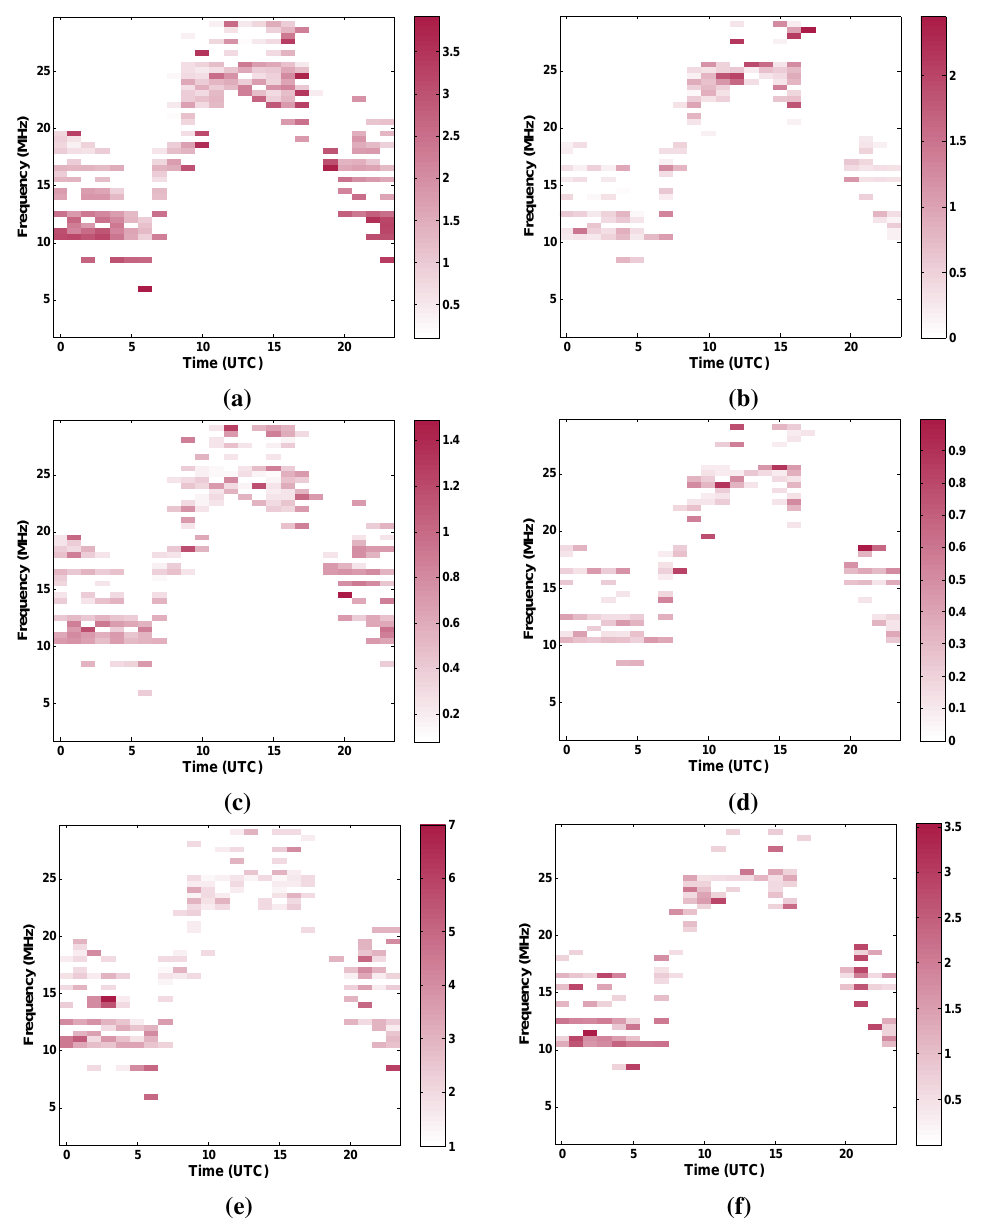
Figure 17. Wideband channel measurements during the campaign of 2014: ( a ) mean of delay spread (in ms); ( b ) standard deviation of delay spread (in ms); ( c ) mean of Doppler spread (in Hz); ( d ) standard deviation of Doppler spread (in Hz); ( e ) mean of the number of paths; and ( f ) standard deviation of the number of